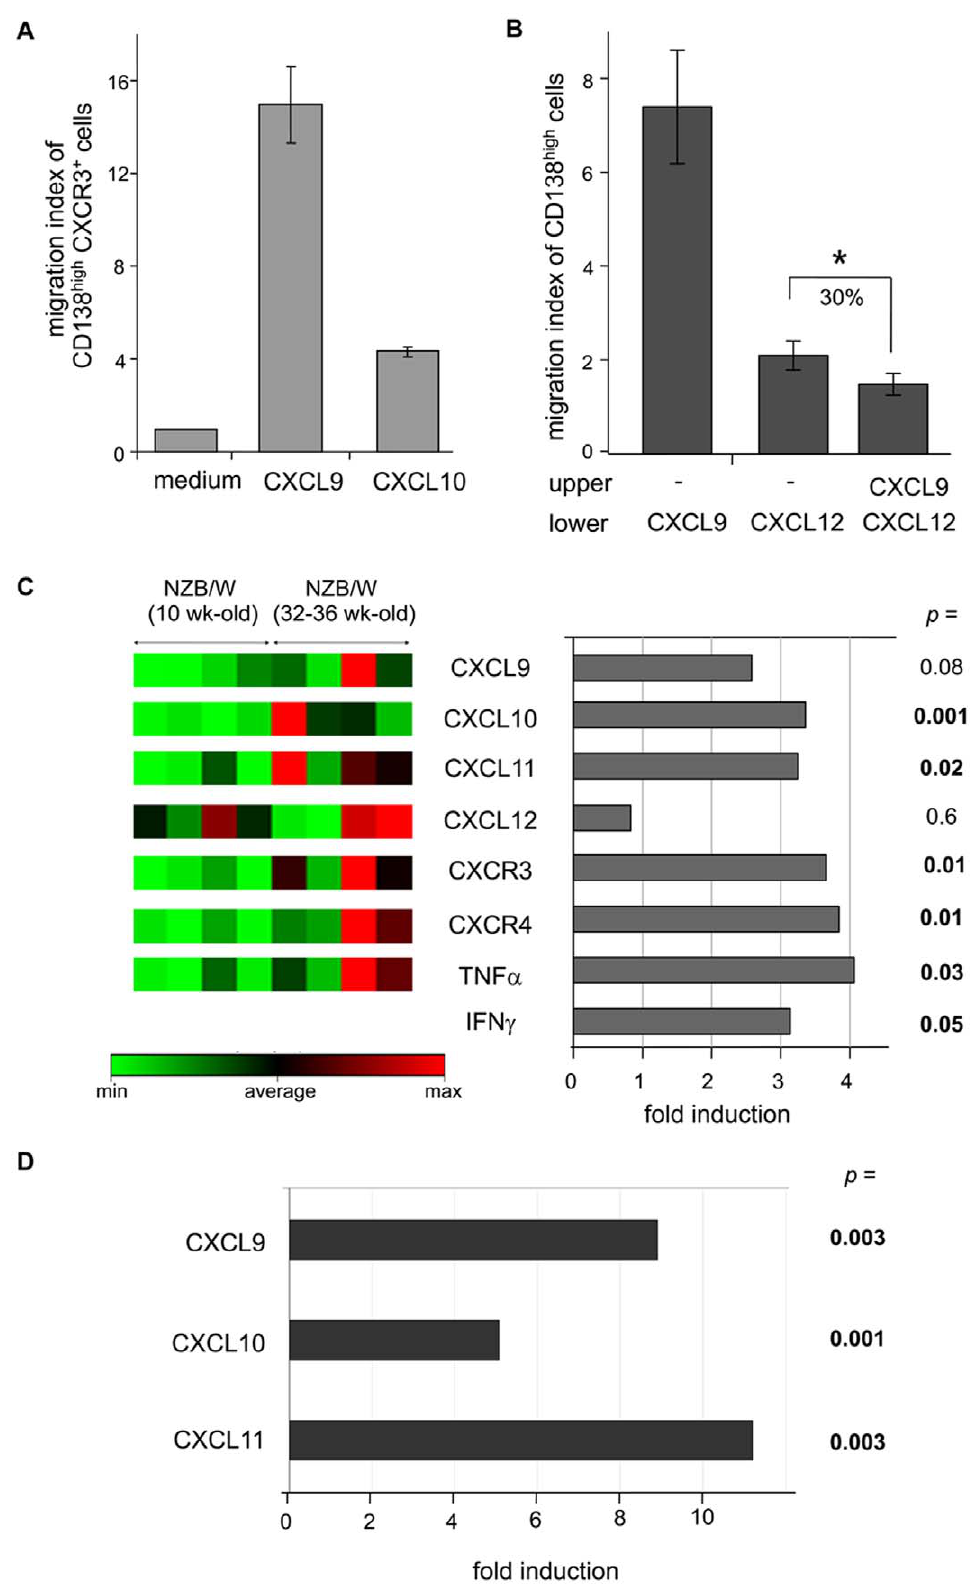
Figure 5. Migration of CD138 high CXCR3 + plasma cells towards inflammation-related chemokines, which are overexpressed in the kidneys of diseased NZB/W mice. A) CD138-enriched splenocytes of NZB/W mice were tested for their chemotactic responsiveness to CXCL9 and CXCL10 in a Transwell migration assay. After a 2 h-incubation, cells which had migrated (lower chamber) were harvested and analyzed by flow